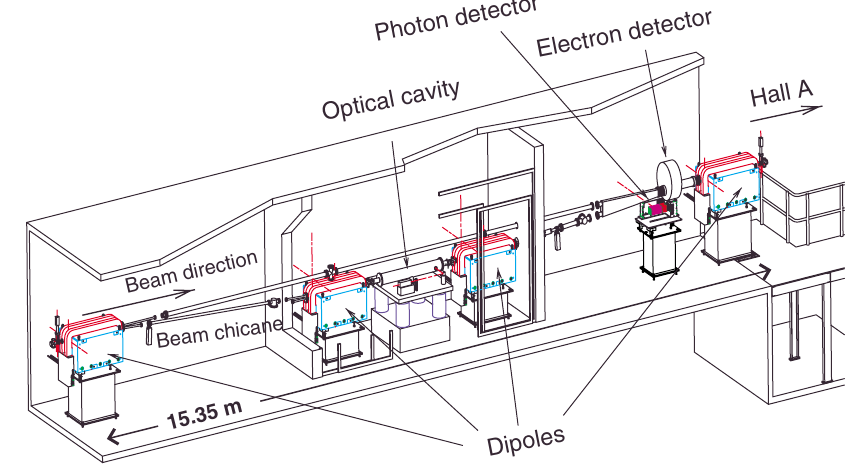
FIG. 3. (Color) Schematic of the Hall A Compton polarimeter.